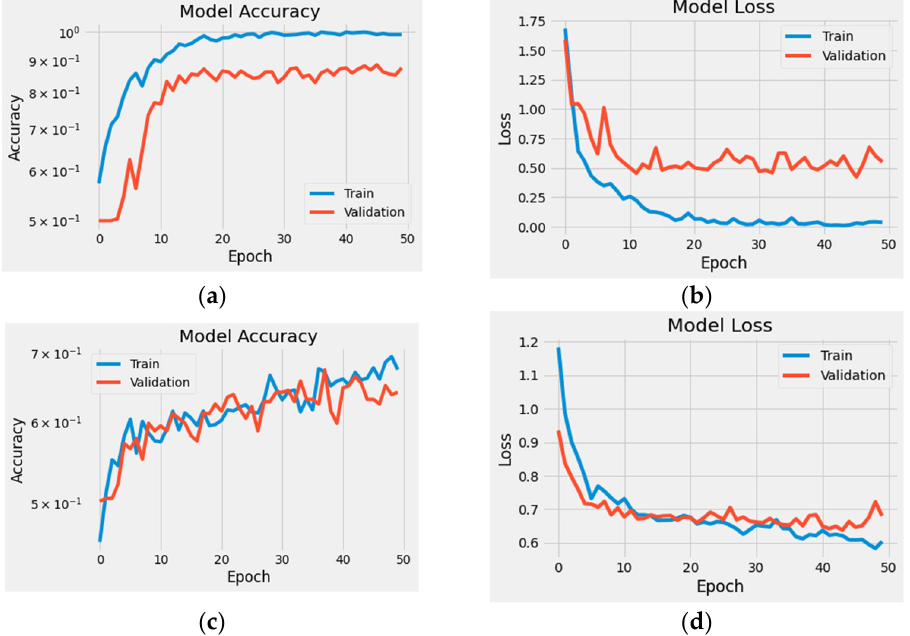
Figure 14. Deep learning models for binary-class scenario learning and performance curves ( a ) Ac- curacy for 1D CNN, ( b ) Loss for 1D CNN, ( c ) Accuracy for C-CNN, ( d ) Loss for C-CNN.